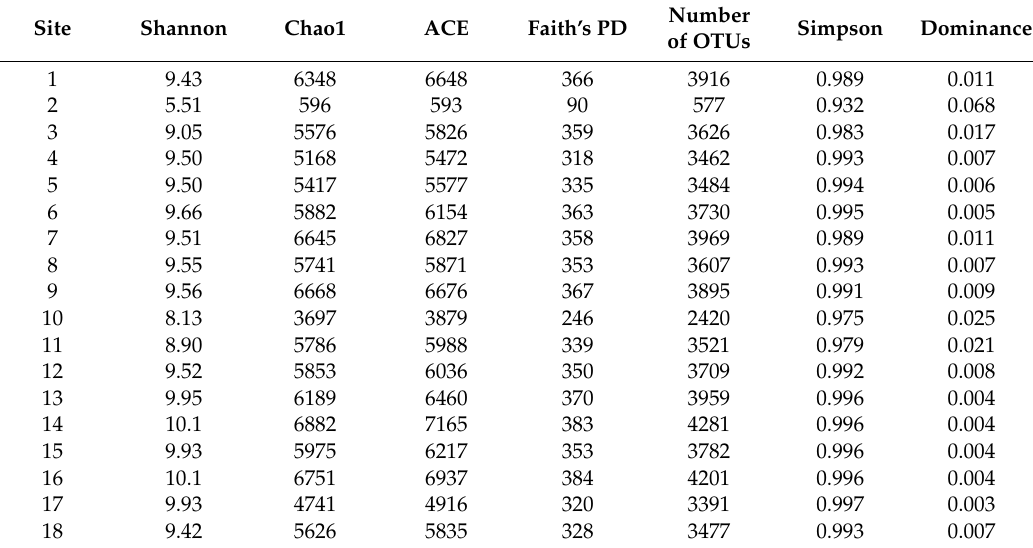
Table 2. The alpha diversity of the sampling sites in Lake